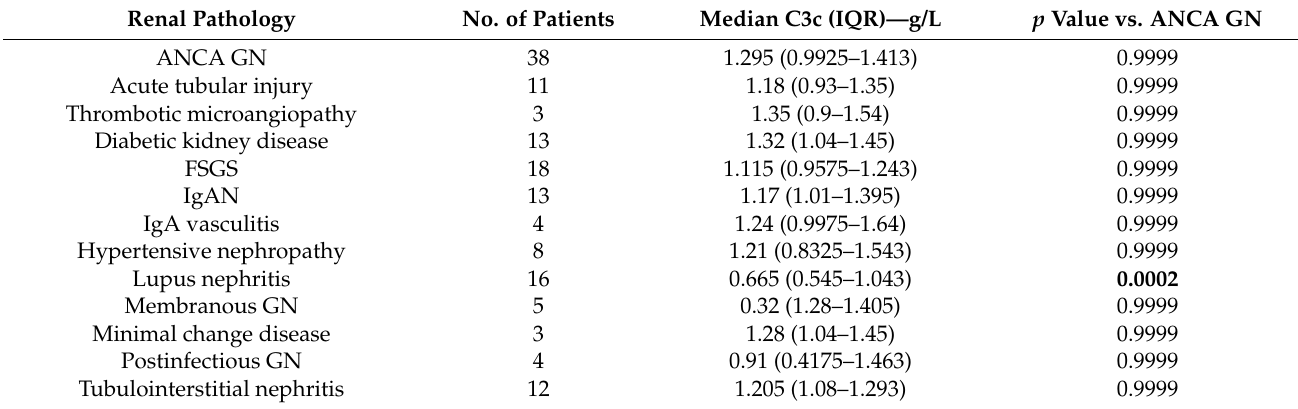
Figure 2. Circulating levels of C3c and C4 in ANCA GN are comparable to the majority of other renal pathologies. ( A , B ) The scatter dot plots represent medians and IQR with individual data points summarizing levels of circulating C3c and C4 in ANCA GN (purple dots), acute tubular injury, thrombotic microangiopathy, diabetic kidney disease, FSGS, IgAN, IgA vasculitis, hypertensive nephropathy, lupus nephritis, membranous GN, minimal change disease, postinfectious GN and tubulointerstitial nephritis (all in grey dots). Abbreviations: ANCA, anti-neutrophil cytoplasmic antibodies; C3c, complement factor 3 conversion product; C4, complement factor 4; FSGS, focal segmental glomerulosclerosis; GN, glomerulonephritis; IgAN, IgA nephropathy. Table 4. Levels of circulating C3c among different renal pathologies (normal range: 0.82–1.93